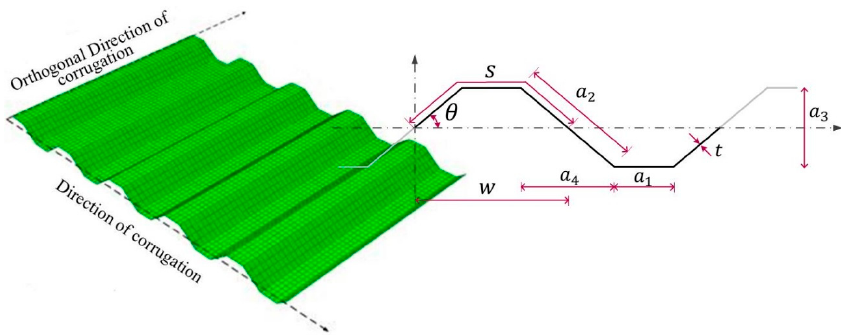
Figure 1. Shape parameter of a trapezoidal-corrugated steel plate.